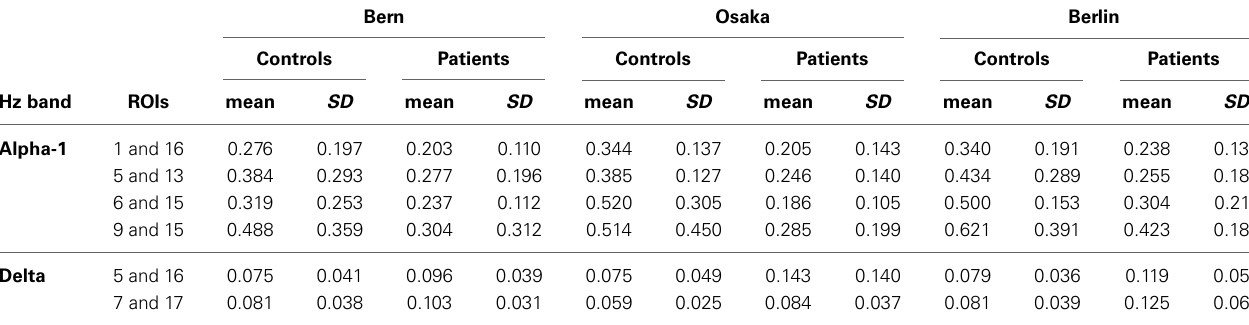
Table 2 | The connectivity values of the 6 qualifying connectivities from the three